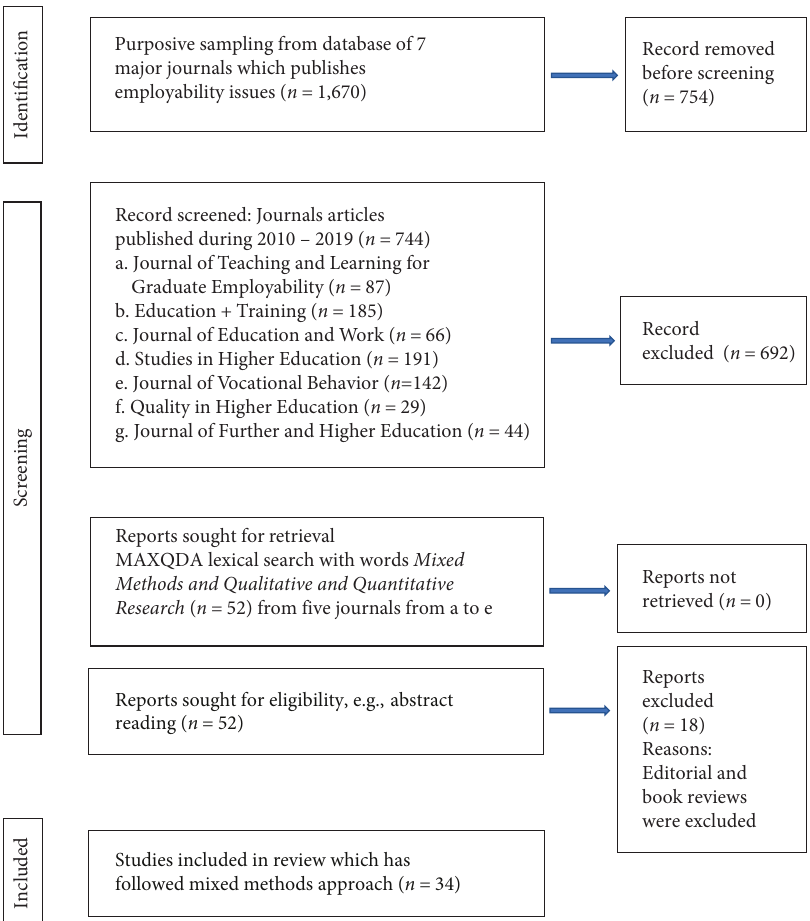
F IGURE 1: Article search and selection procedure using the PRISMA fl ow